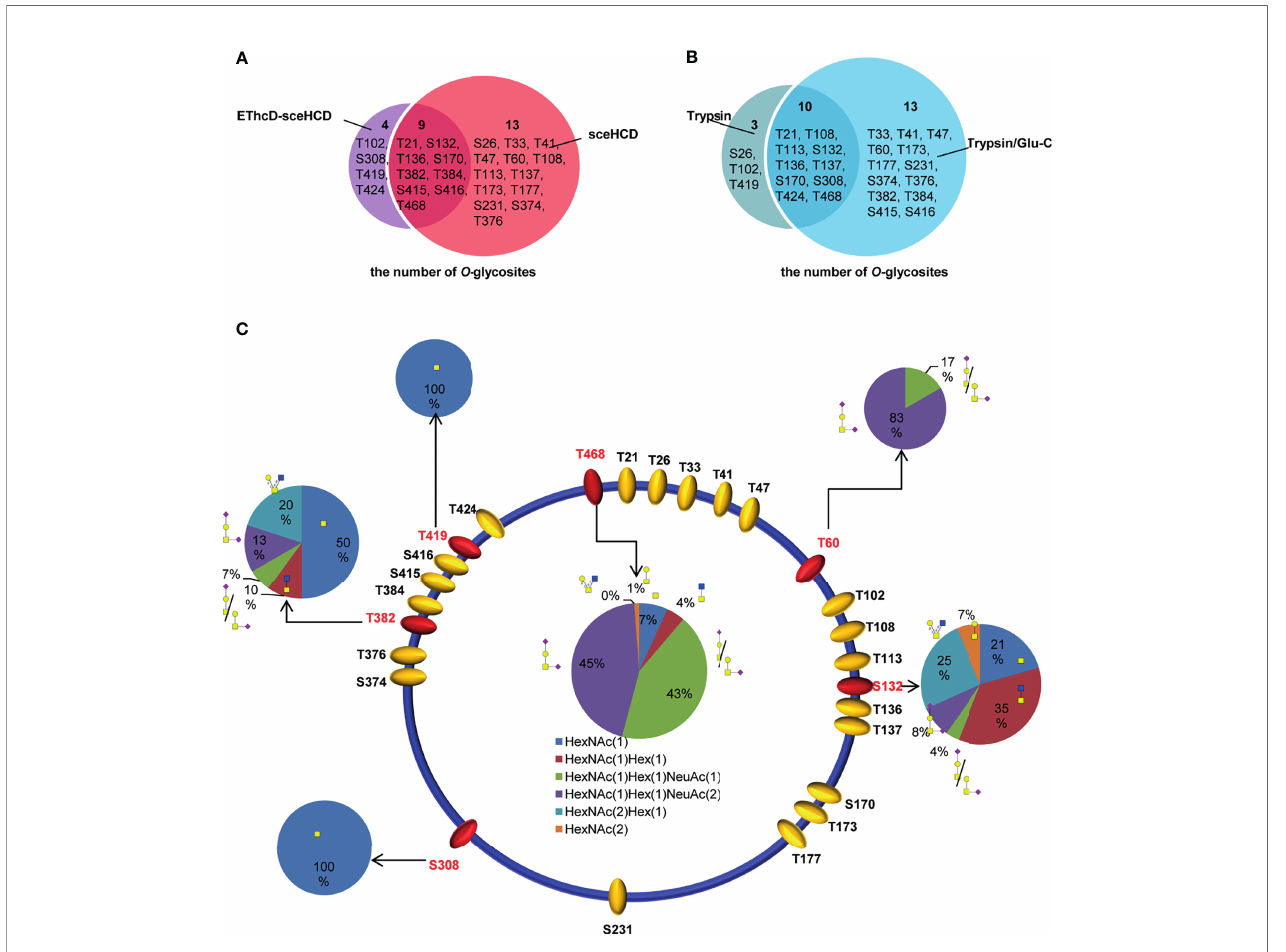
FIGURE 7 | Site-speci fi c O-glycosylation of HIV-1 gp120 protein. (A) The number of O-glycans in gp120 identi fi ed using sceHCD-MS/MS and EThcD-sceHCD-MS/ MS. (B) The number of O-glycosites in gp120 that had been digested by trypsin or trypsin/Glu-C. (C) Different types and relative ratios of O-glycans on each unambiguously (red oval) or ambiguously (yellow oval) assigned O-glycosites of the recombinant HIV-1 gp120 protein expressed in human